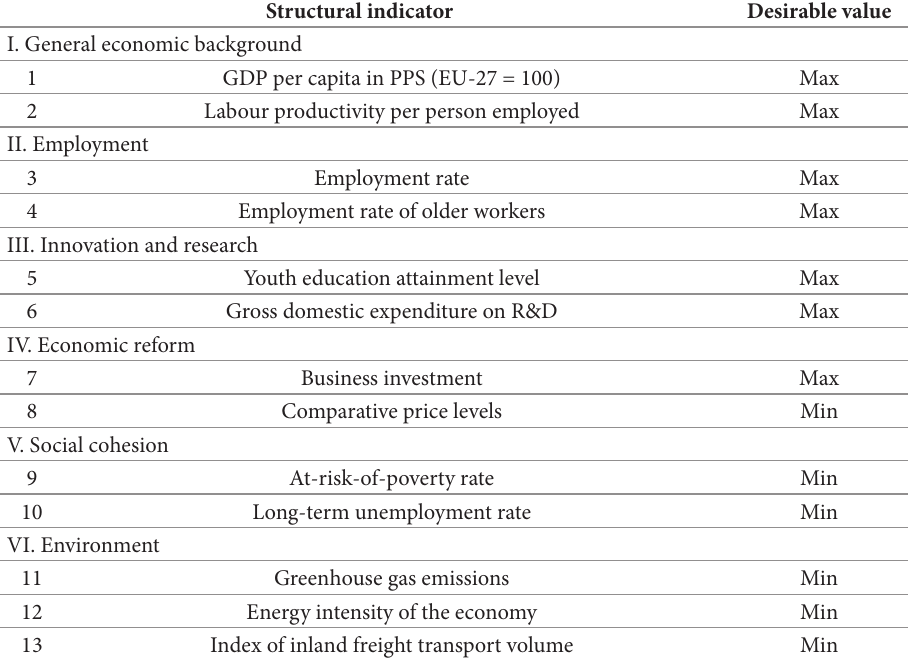
Table 1. Structural indicators used in evaluation of Lithuania’s position in the EU Structural